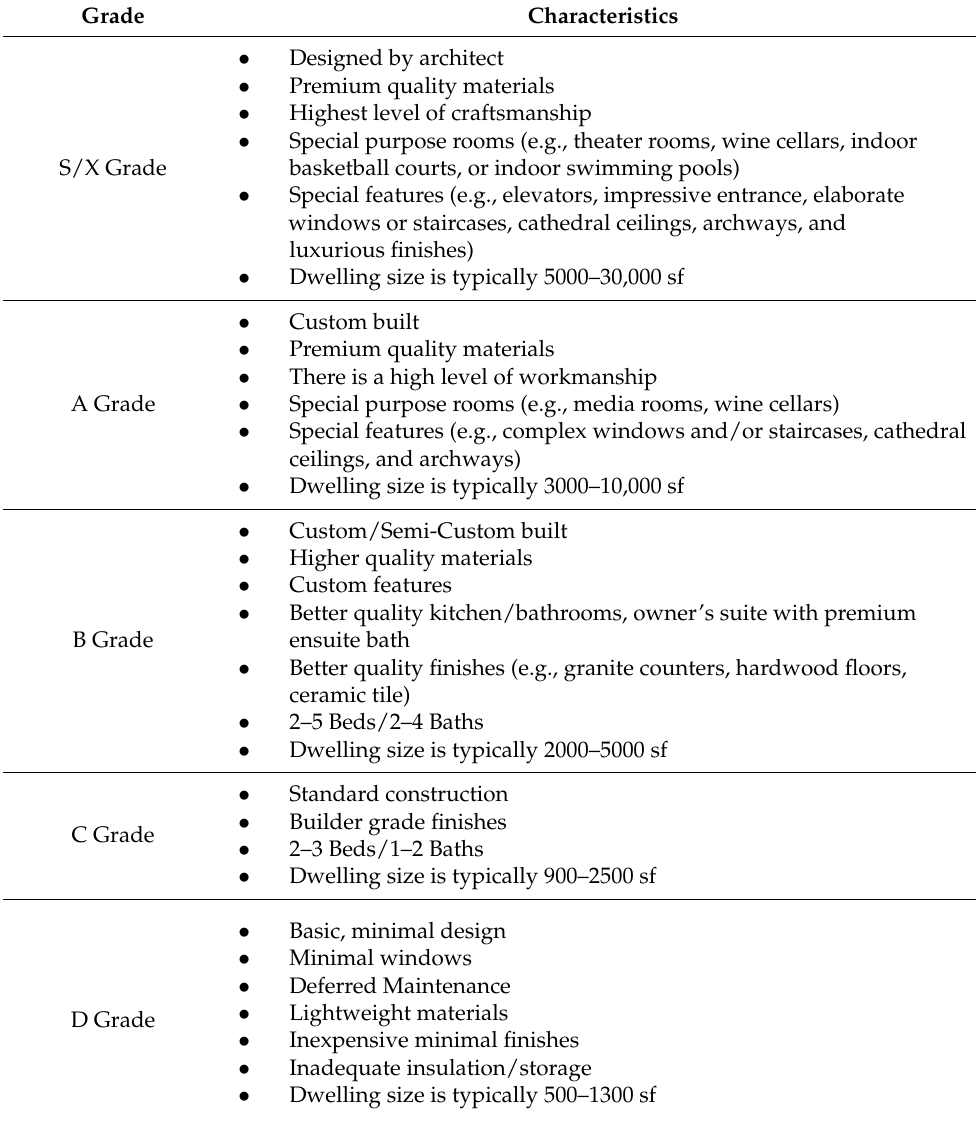
Table A1. Building quality grade categories—Franklin County,